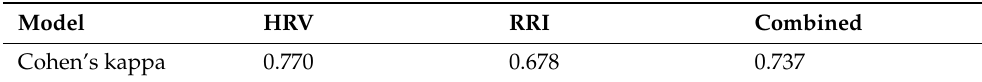
Table 11. Cohen’s kappa representing agreement between predictions of two distinct samples from the same subject.